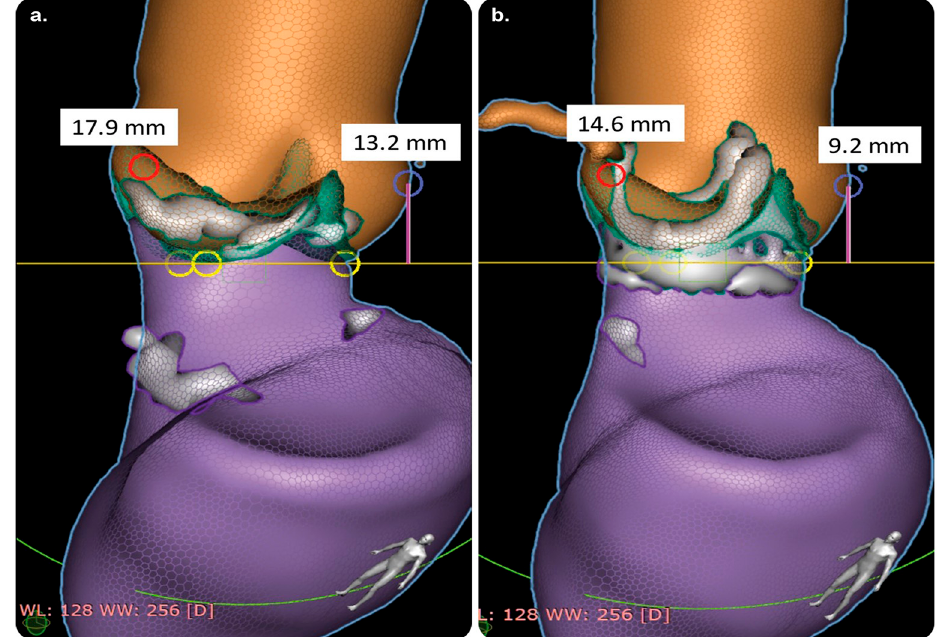
Figure 10. HeartNavigator software and its role in intuitive display. CT assessment of coronary heights before and after aortic valve replacement with implantation of the ‘RD-AV EDWARDS INTUITY’ system. ( a ) Preoperative RCAA and LCAA heights (red and blue circles, respectively; distance from the annular plane to the left coronary ostium). ( b ) Postoperative RCAA and LCAA heights (red and blue circles, respectively; distance from the annular plane to the right coronary ostium). Abbreviations: CT, computed tomography; LCAA: left coronary artery-to-annulus; RCAA: right coronary artery-to-annulus. Reprinted from “Effect of conventional and rapid-deployment aortic valve replacement on the distance from the aortic annulus to coronary arteries” by Coti et al. [60] with written approval from the corresponding author and publisher (Interactive CardioVascular and Thoracic Surgery; Copyright 2021).